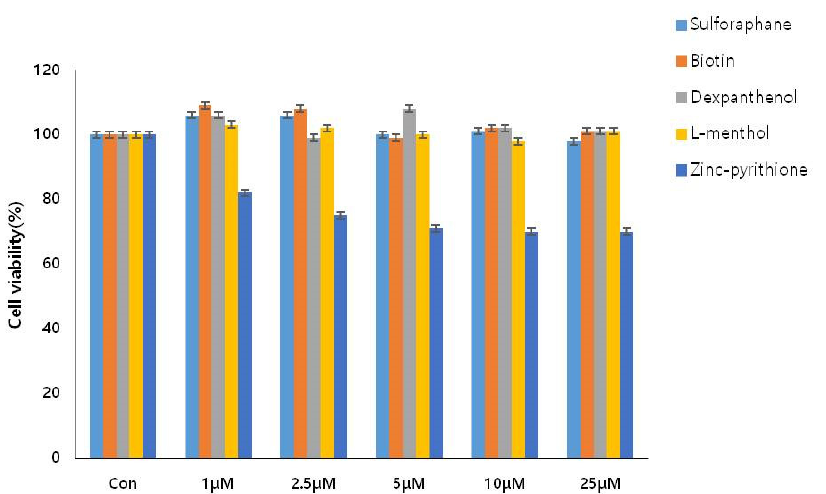
Figure 3. Effects of sulforaphane, biotin, dexpanthenol, l-menthol, and zinc pyrithione on cell viability using Hepa1c1c7 cells. The cells were treated with various concentrations (1–25 µ M) of sulforaphane, biotin, dexpanthenol, I-menthol, and zinc pyrithione for 24 h, respectively. Cell survival was measured by MTT assay.